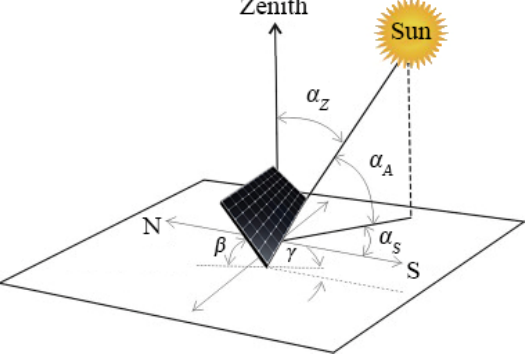
Figure 1. Illustration to the definition of the tilt angle, the solar azimuth angle. and the azimuth orientation.